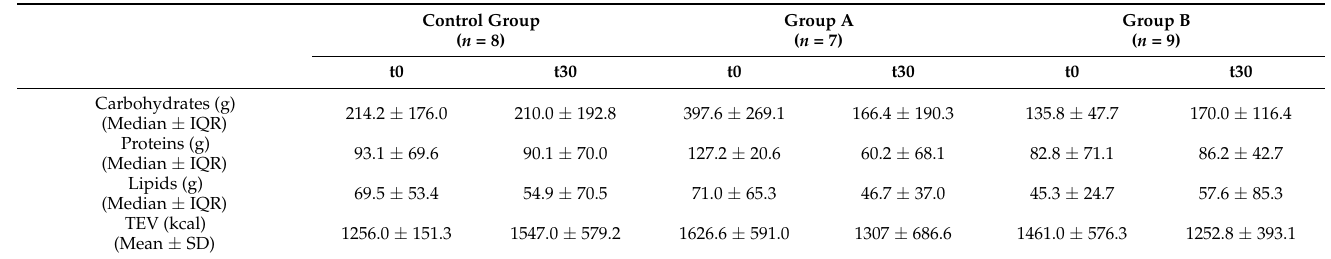
Table 2. Food consumption of adult women subjected to cryolipolysis on one (group A) or multiple areas of the body (group